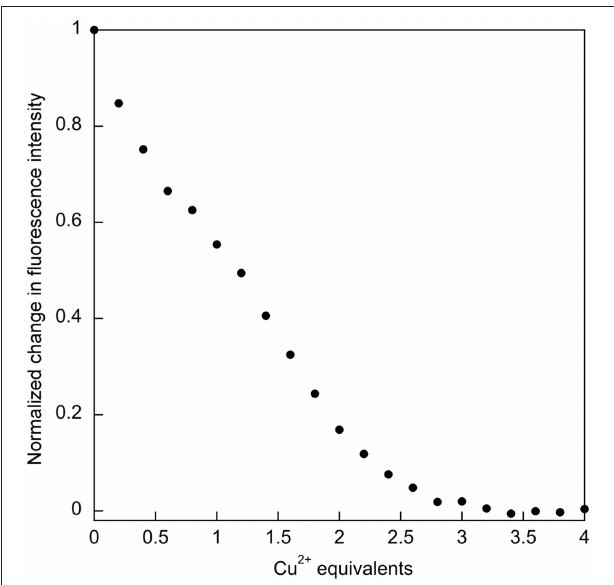
FIGURE 4 | Titration of SUP with CuSO 4 with binding followed by quenching of tyrosine fluorescence ( λ ex = 260nm; λ em = 305nm), indicates that two equivalents of Cu 2 + bind.